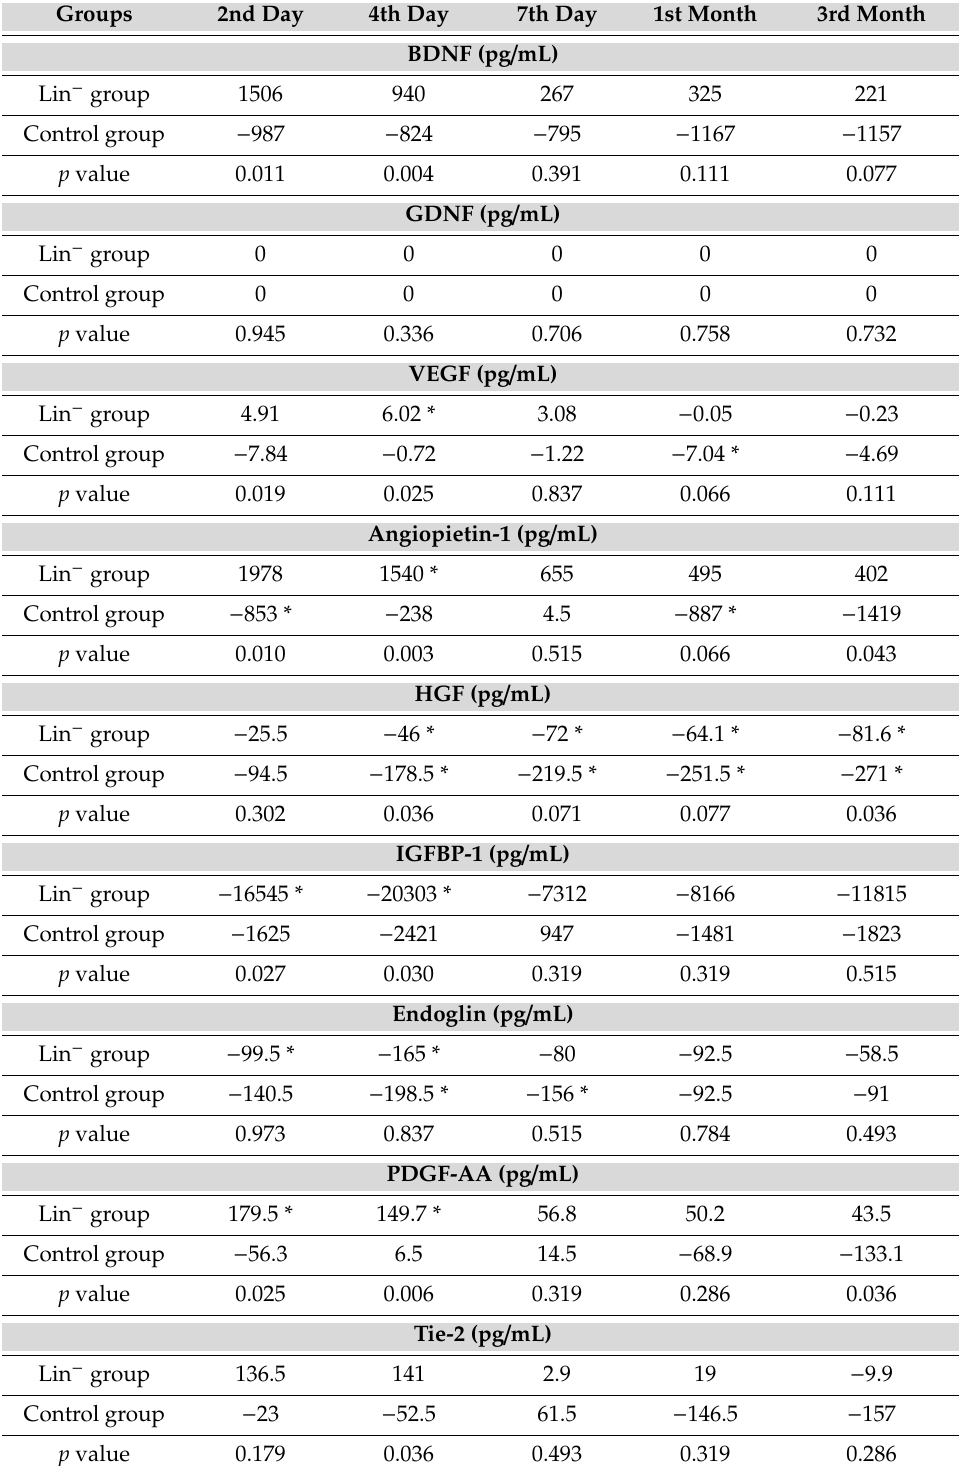
Table 5. The di ff erences between the following time points and day 0 (baseline) in plasma levels of BDNF, GDNF, VEGF, angiopoietin-1, HGF, IGFBP-1, endoglin, PDGF-AA, Tie-2, endothelin-1, and bFGF in the Lin − group and in the control